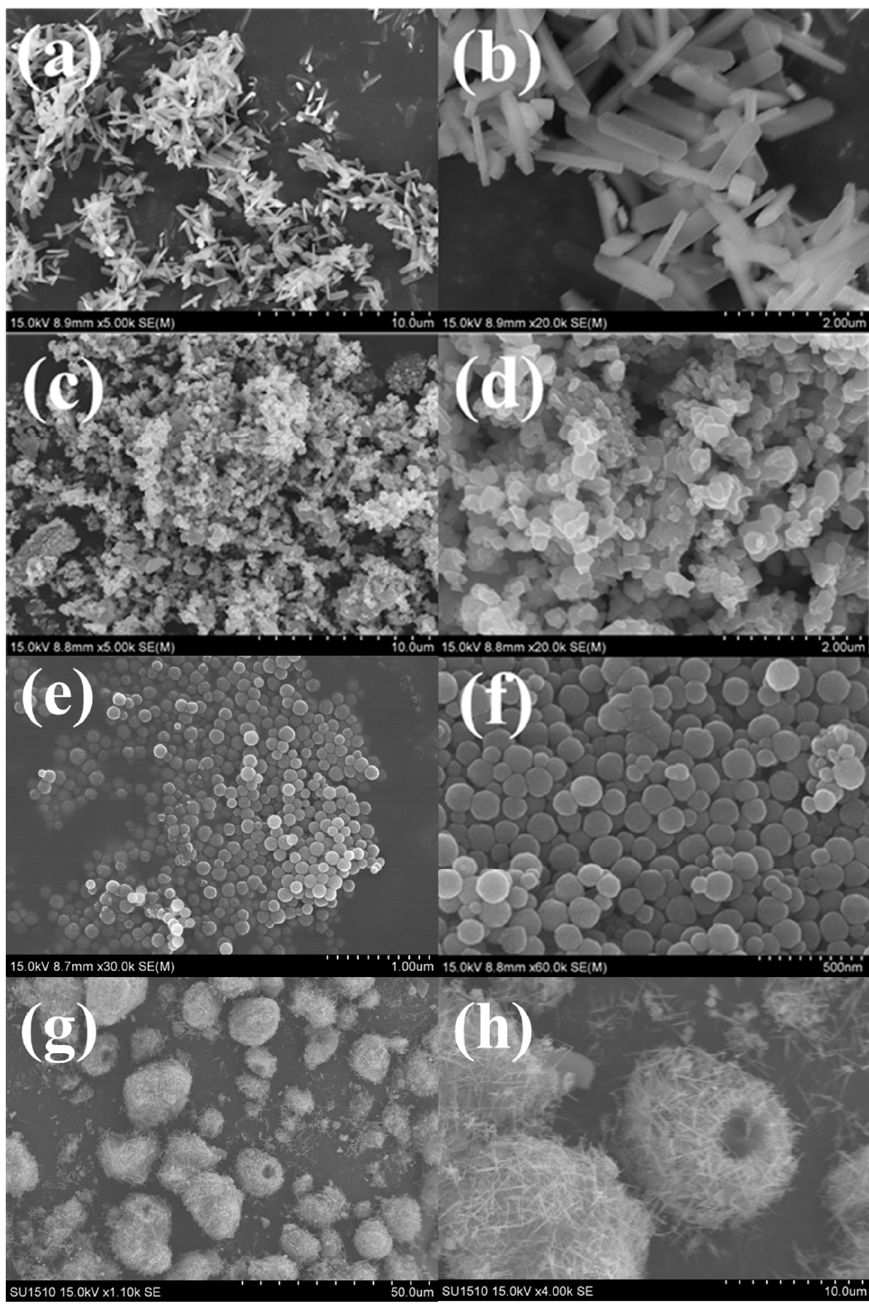
Figure 8. SEM images of the as-prepared ( a , b ) Cu 2 O/ZSM-5, ( c , d ) Cu 2 O/Fe 2 O 3, ( e , f ) Cu 2 O/CeO 2 , and ( g , h ) Cu 2 O/ α -MnO 2 catalysts.